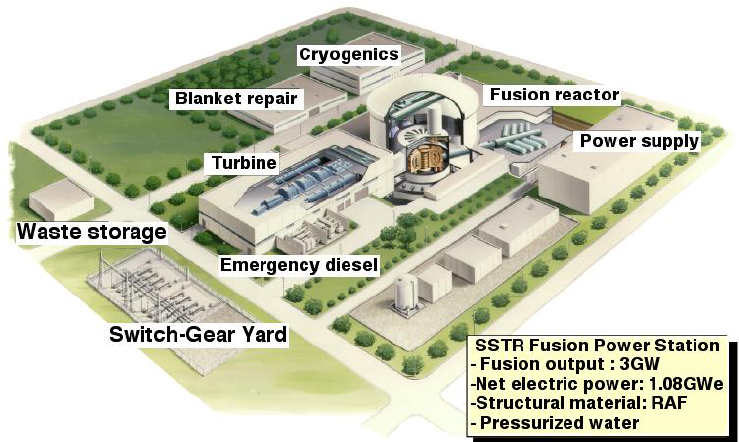
Figure 8. Bird’s eye view of SSTR(Steady State Tokamak Reactor) plant layout